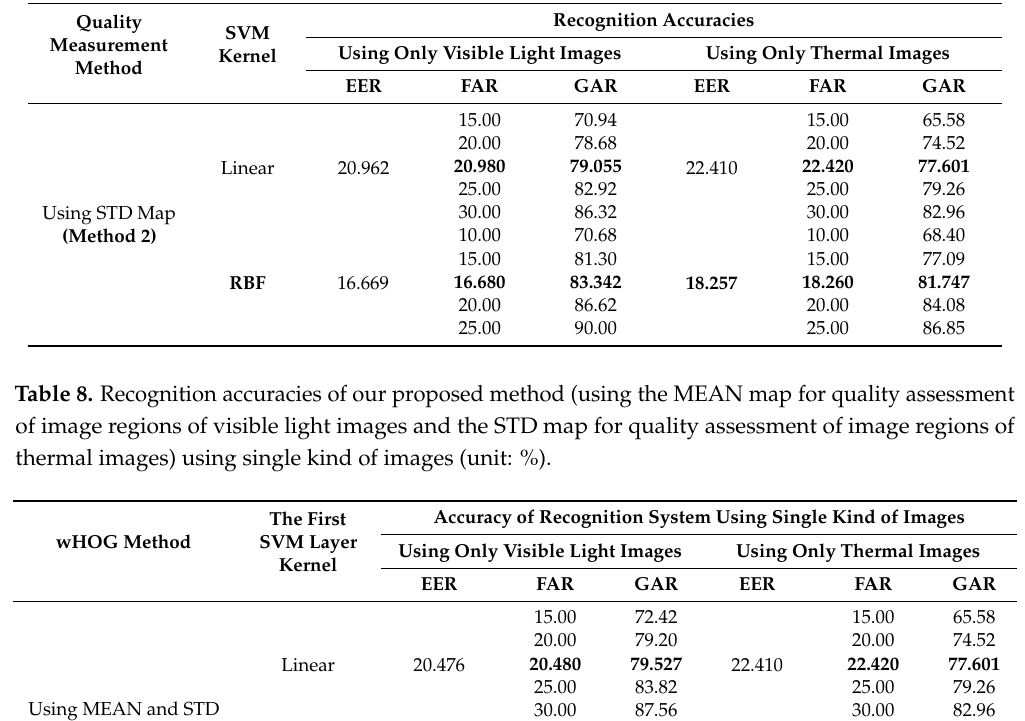
Table 7. Recognition accuracies of our proposed method using the STD map for quality assessment of image’s regions for both visible light and thermal images (unit: %).